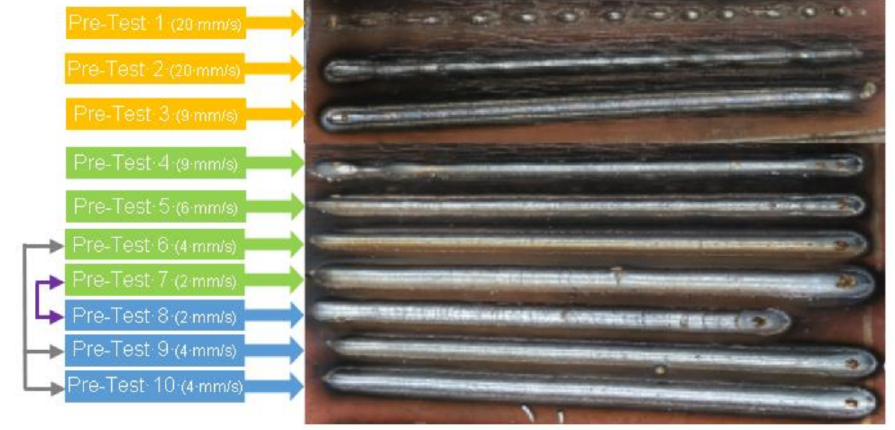
Figure 6. Selection of the optimum beads from pre-tests and confirmatory tests